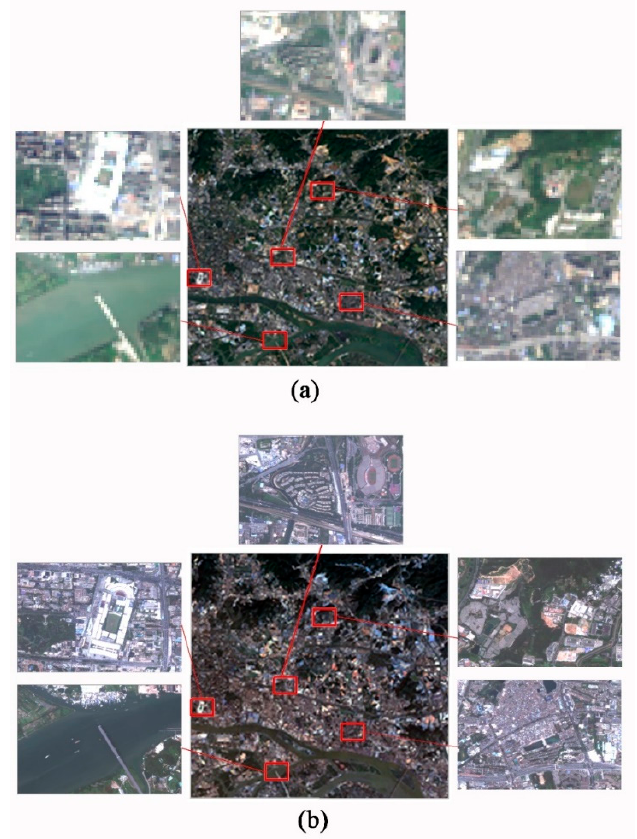
Figure 2. RGB images in natural colors from ( a ) Landsat 8 OLI, and ( b ) GF-2. Table 1. The detail of remote sensing data.